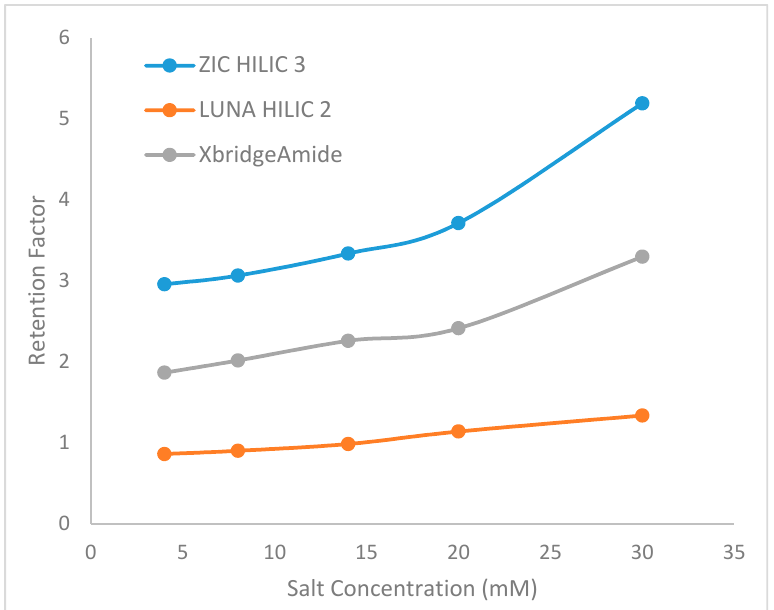
Figure 2. Cytosine retention factors on 25 polar stationary phases measured in the mobile phase containing 85% and 90% acetonitrile. Ammonium acetate concentration remains at 5 mM.